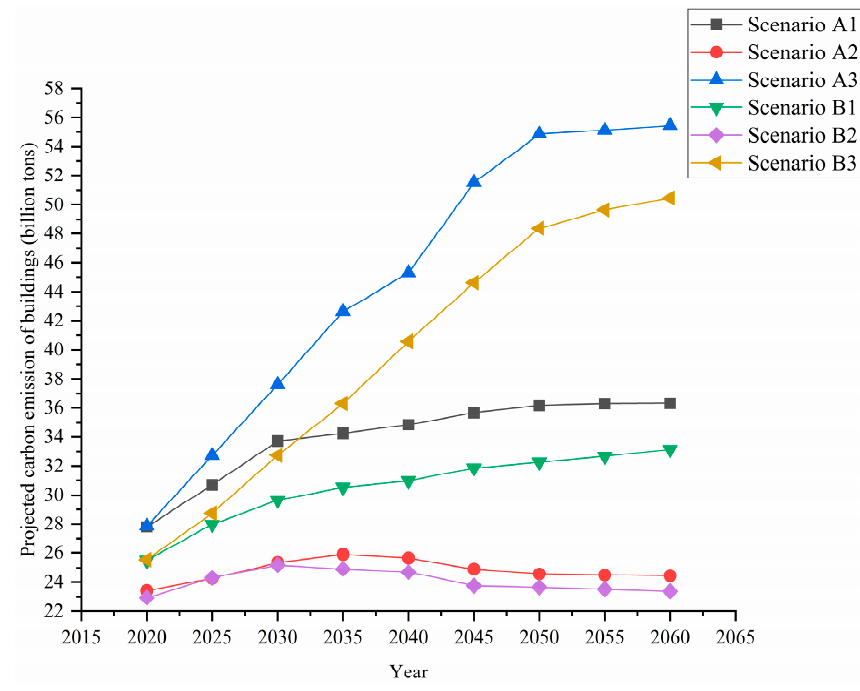
Figure 9. Projected carbon emissions in the building industry (billion tons).